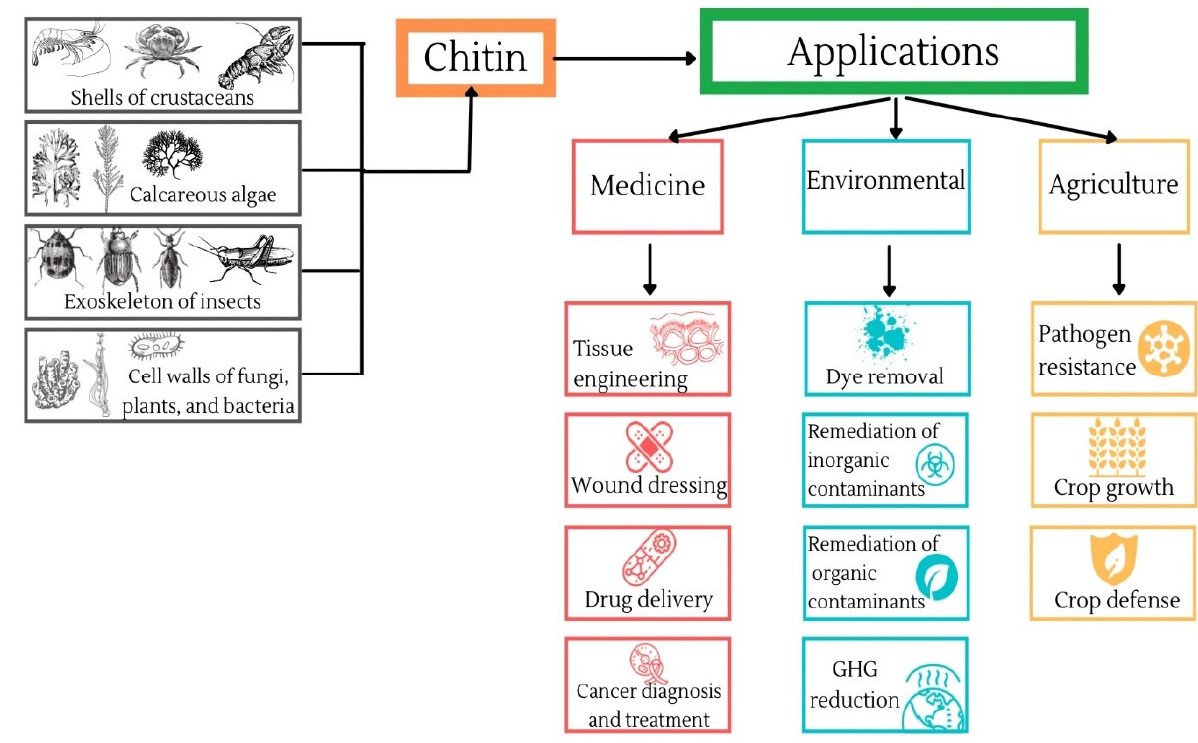
Figure 1. Sources of chitin and its applications at a glance.